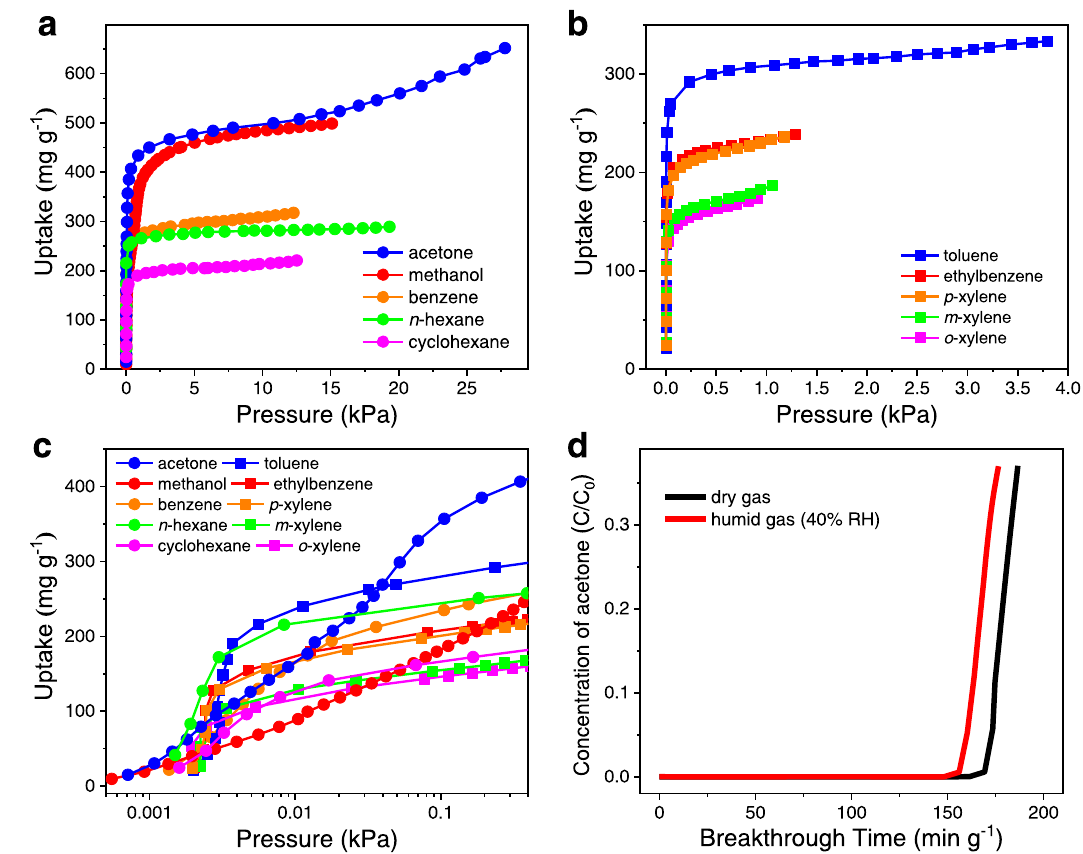
Fig. 5 | VOCs adsorption studies for PCN-250(Fe 2 Co). a for relatively low boiling point VOCs (methanol, acetone, benzene, n -hexane, and cyclohexane) and b for relatively high boiling point VOCs (toluene, ethylbenzene, o -xylene, m -xylene, and p -xylene)recordedat25°C. c Zoom-inviewforadsorptiondataatthelow-pressure range (below 0.4kPa). d Breakthrough curves for dry and humid air (RH=40% at